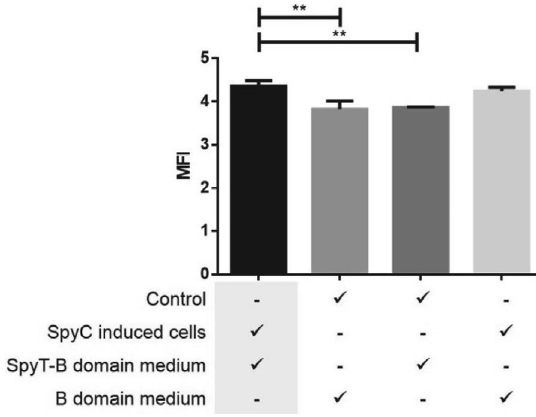
Fig. 4. Flow cytometric analysis of binding of L. lactis -secreted Spy- Tag (SpyT)-B domain to L. lactis -displaying SpyCatcher (SpyC). FITC-conjugated human IgG was used for detection. Mean fluores- cence intensity (MFI) values of SpyC-displaying bacteria with add- ed SpyT-B domain-containing medium were compared to those of the controls by using Student’s t test. * p<0.05, **